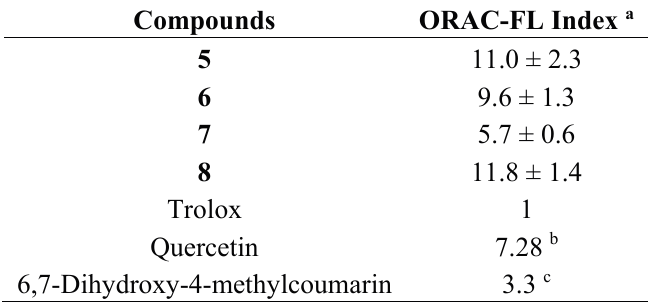
Table 2. ORAC-FL values calculated for the studied and reference